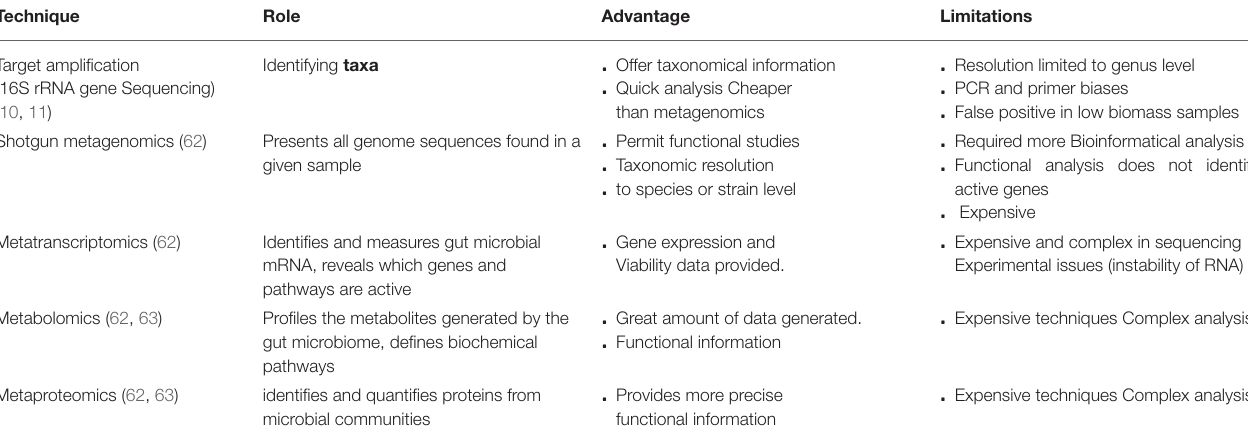
TABLE 1 | Commonly used metagenomic techniques in microbiome analysis.